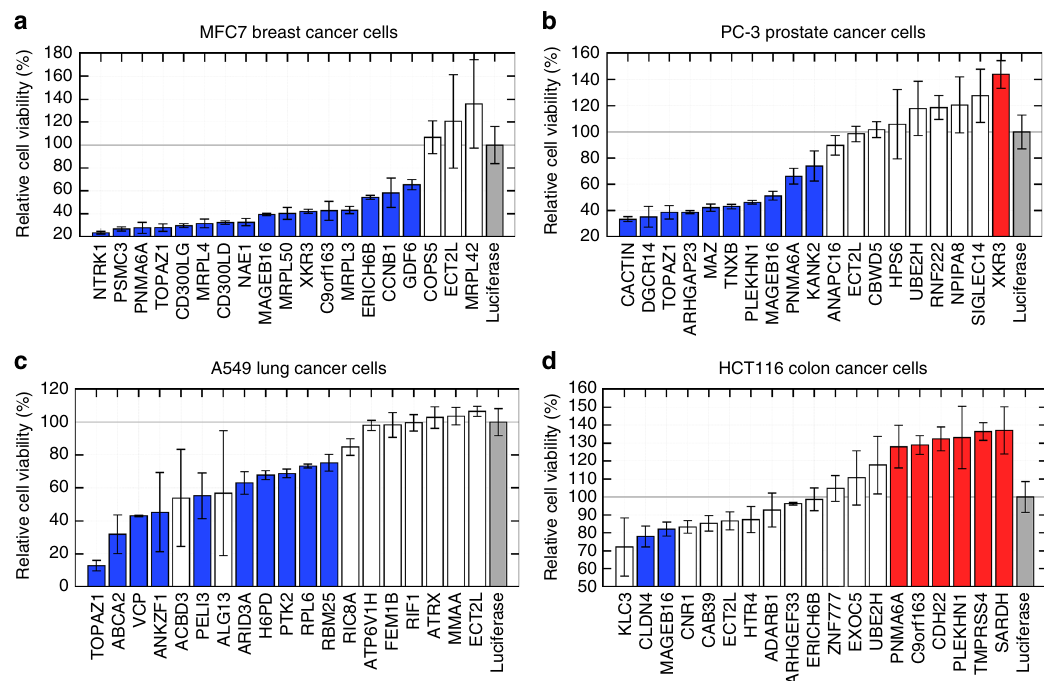
Fig. 3 Cell viability changes in cancer cell lines after knockdown of iCell rewired genes. For each of MCF7 breast cancer ( a ), PC-3 prostate cancer ( b ), A549 lung cancer ( c ), and HCT116 colon cancer ( d ) cell lines, cells were seeded in triplicates into 96-well plates and were transfected with indicated esiRNAs 24 h after seeding. The esiRNAs correspond to the 20 top iCell hits minus HLA-DQA2 (because it was not in our library), to which we added esiLuciferase as control. Seventy-two hours after transfection, Presto Blue cell viability assays were performed. Cell viability is calculated relative to the corresponding esiLuciferase controls (set to 100%). For each cell type and for each gene, bars represent the average of the relative changes of cell viability over the triplicate experiments, and the error-bars show the corresponding standard deviations. Bars in blue indicate reduced cell viability in cancer that is statistically different from the control (MWU p value ≤ 5%), bars in red indicate increased cell viability in cancer that is statistically different from the control, and bars in white indicate cell viability changes in cancer cell lines that were not statistically signi fi